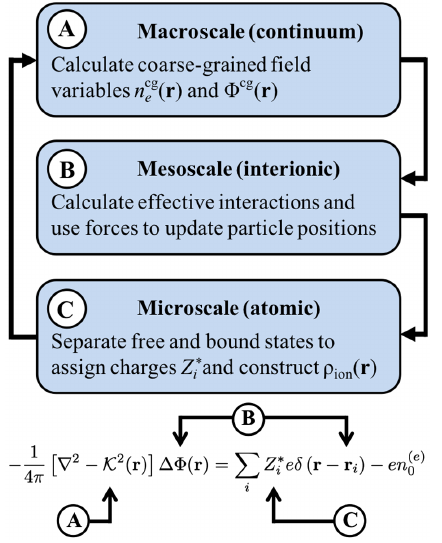
FIG. 2. MOD-MD algorithm. Schematic showing the concur- rent steps at each length scale during each time step within the MOD-MD